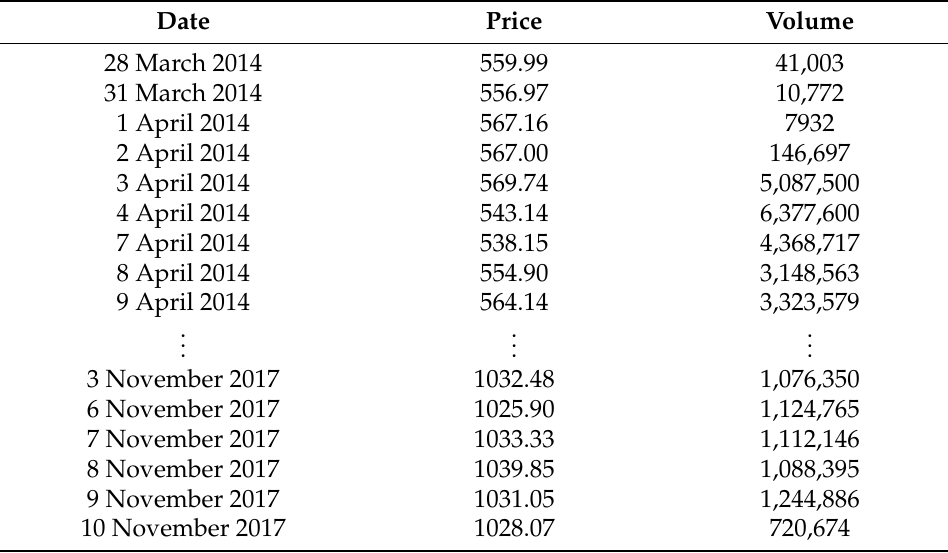
Table 1. Total Resource on Google from 28 March 2014 to 10 November